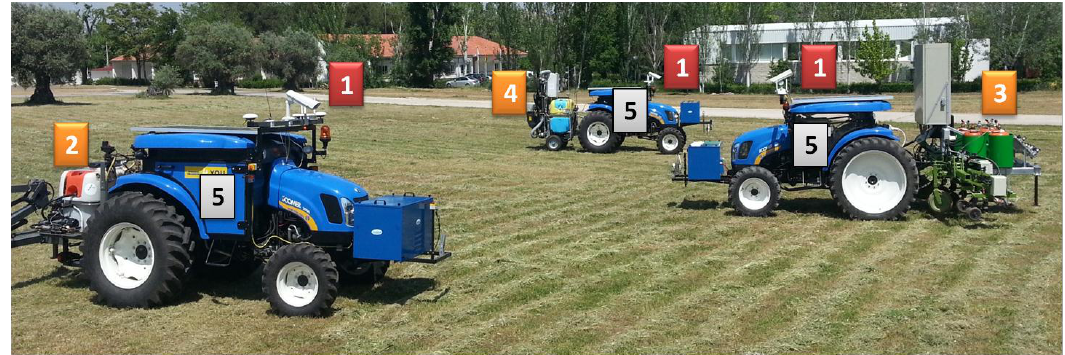
Figure 4. RHEA fleet: (1) Perception systems; (2) sprayer boom; (3) mechanical-thermal tool; (4) air-blast sprayer; and (5) unit